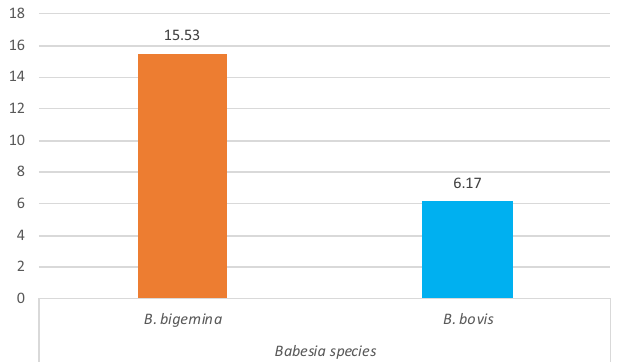
95% C. I. [lower– upper]